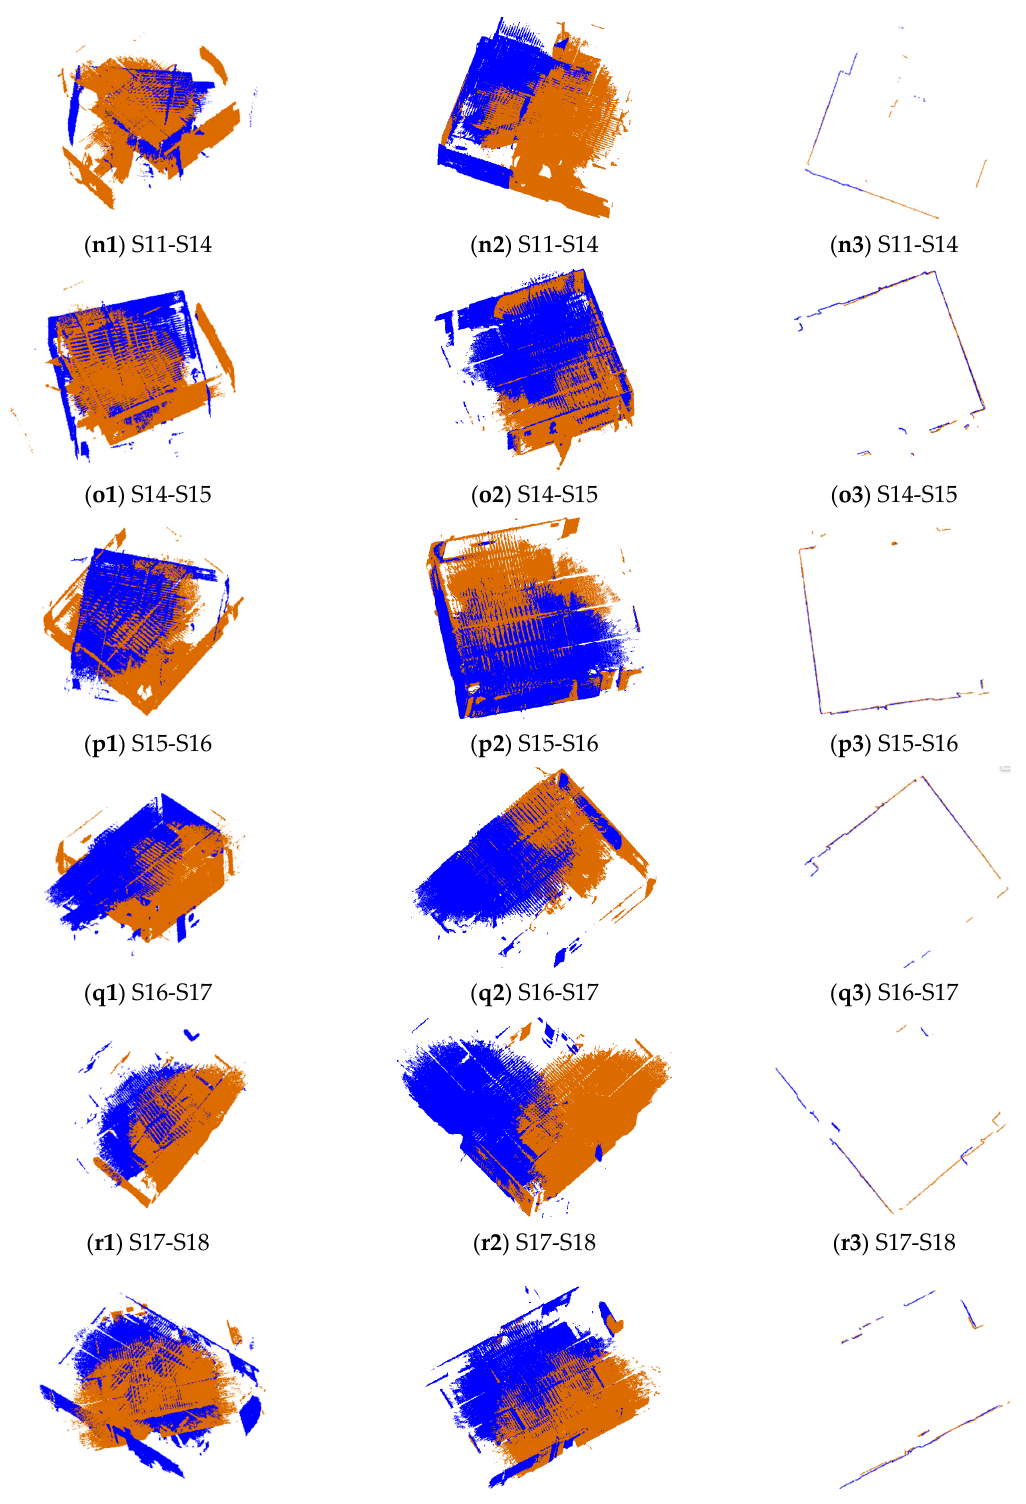
Figure 6. The registration results of 19 pairs of point clouds in dataset CB. The first column is the point clouds before registration, the second column is the point clouds after registration using the proposed method, and the third column is the horizontal section view of the point clouds after registration. The brown points are target points and the blue points are source points.